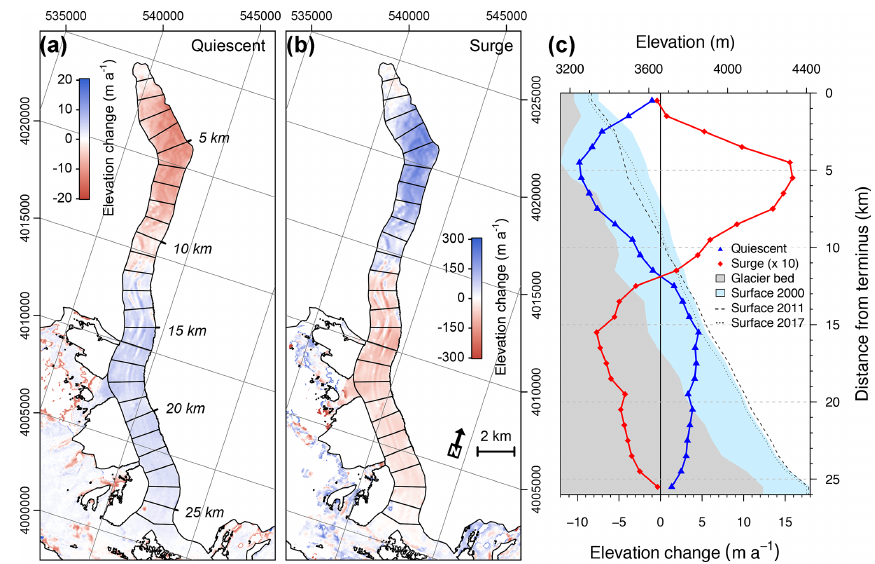
Figure 2. Elevation change rates during the quiescent phase (a) , and during the build-up and surge phase (b) . Mean values per bin are shown in panel (c) . Note that values for the surge phase are shown at 1 order of magnitude smaller than measured. All coordinates are in UTM WGS84 Zone